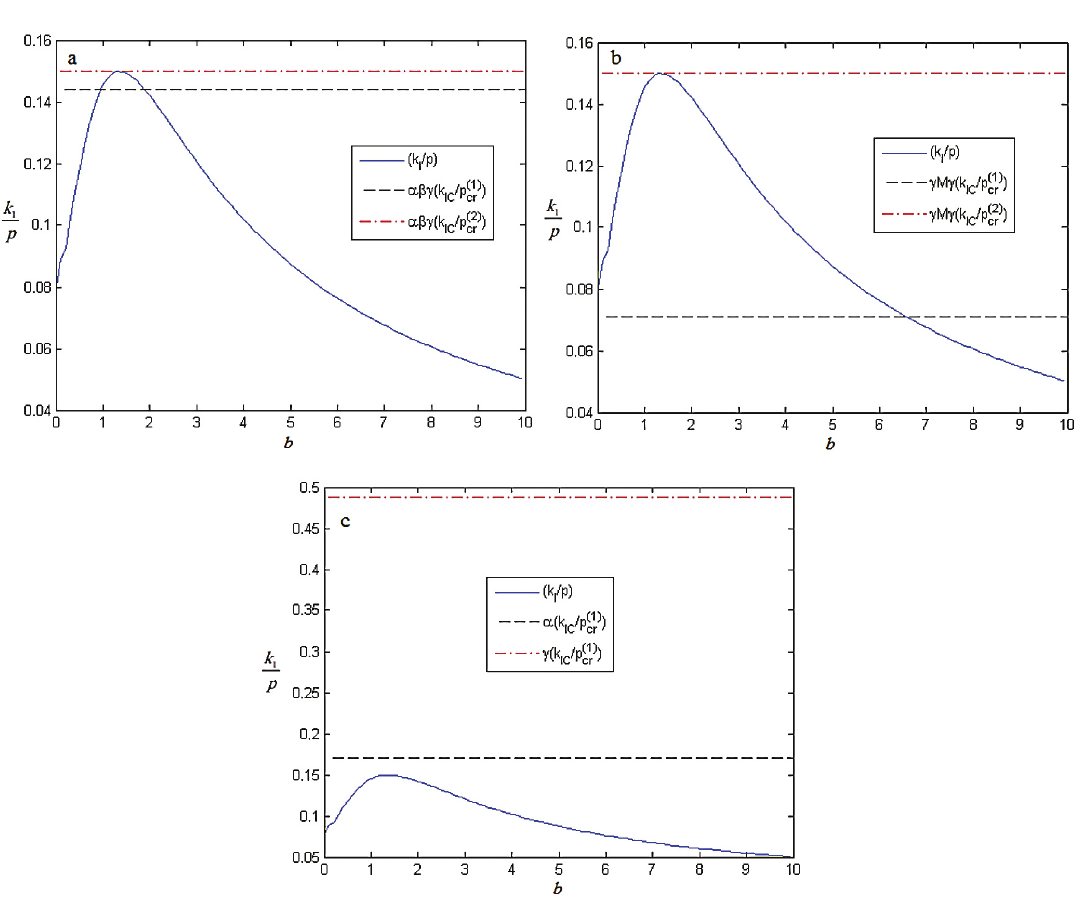
Figure 9. Normalized mode I stress intensity factors and normalized critical stress intensity factor for (a-b)/d=1, η=0.8, d=1: (a) composite αβγ; (b) composite γMγ; (c) original ferrite α and original austenite